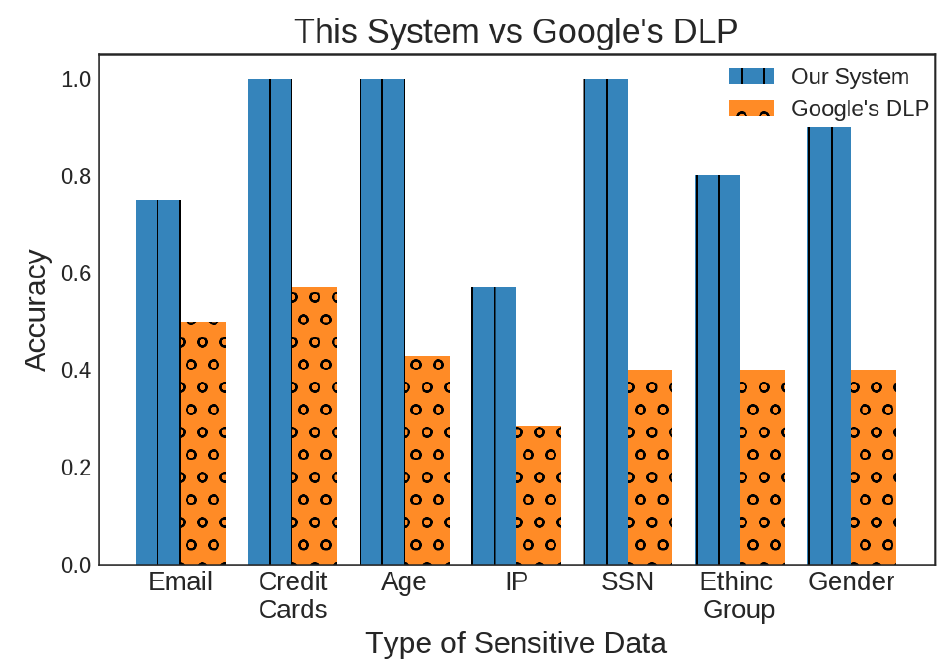
Figure 5. Comparative evaluation between our system and Google’s Data Loss Prevention (DLP)